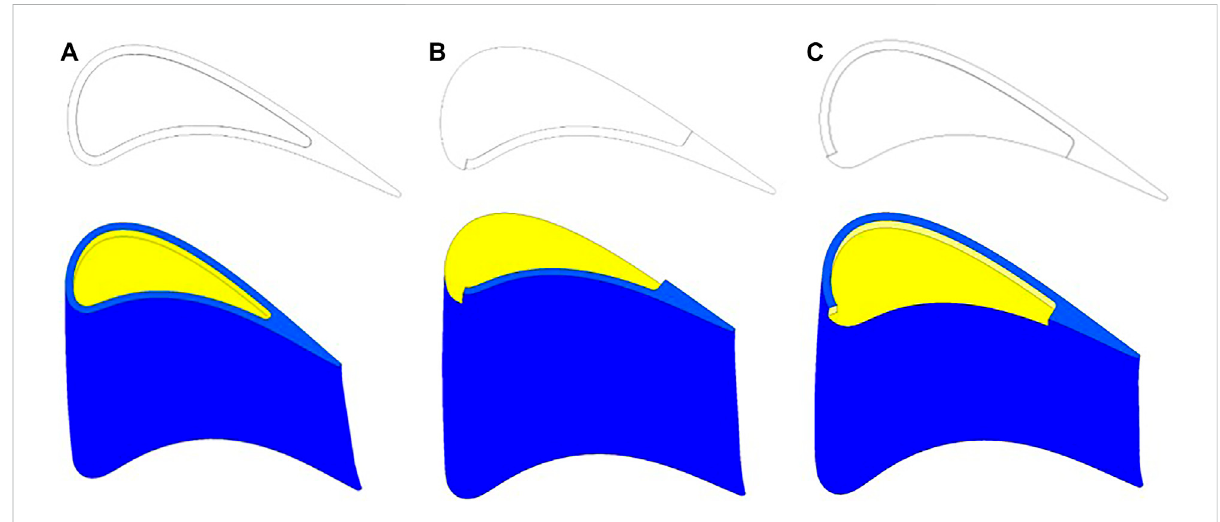
FIGURE 3 Structural diagram of the blade top without the cold air groove. (A) Full rib groove tip structure. (B) Pressure-side partial rib groove blade tip structure. (C) Suction-side partial rib groove blade tip structure.